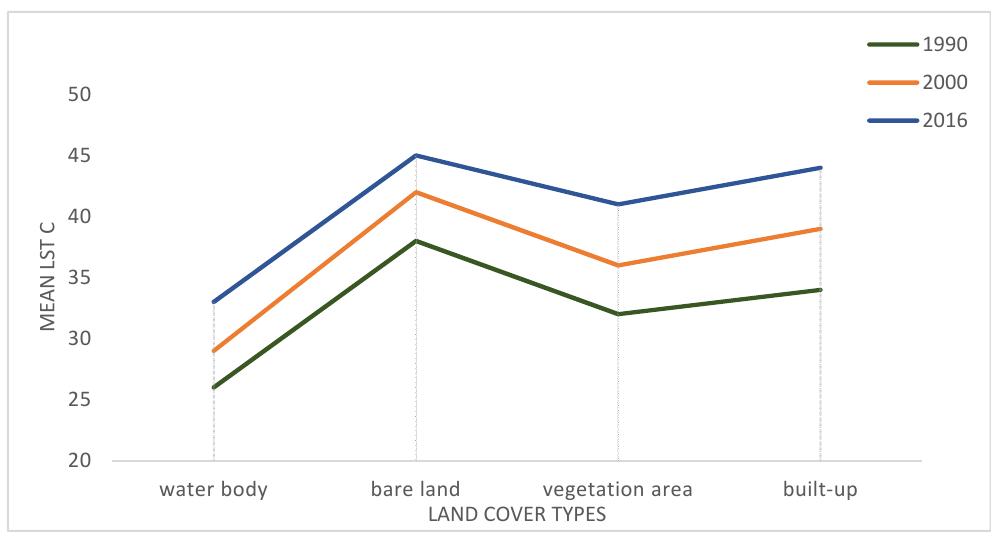
Figure 8. The differences of mean LST over variations of land cover types in 1990, 2000 and 2016.